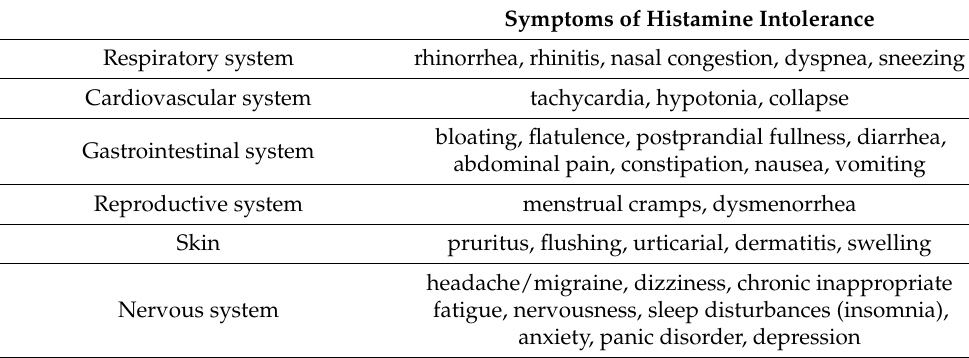
Table 1. Symptoms of histamine intolerance from a specific